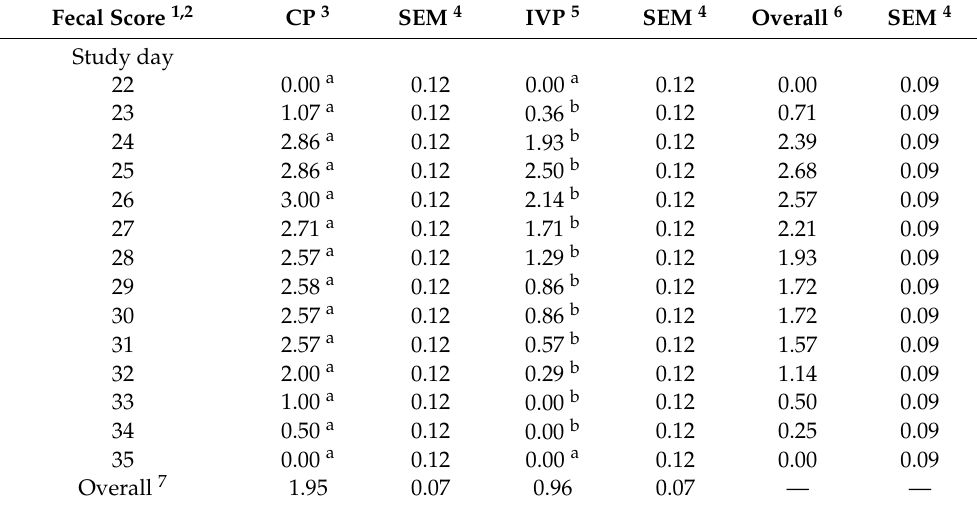
Table 6. Fecal scores of pigs with model adjusted means by treatment groups used to test core antigen bacterin with an immunostimulant on health and performance outcomes when challenged with enteric and respiratory